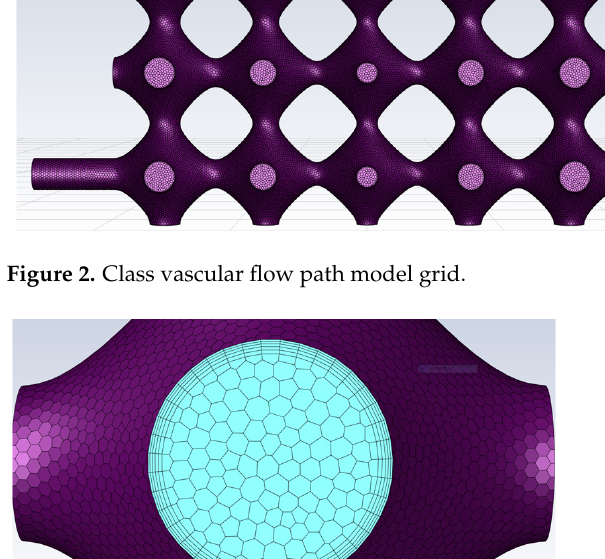
Figure 2. Class vascular flow path model grid.